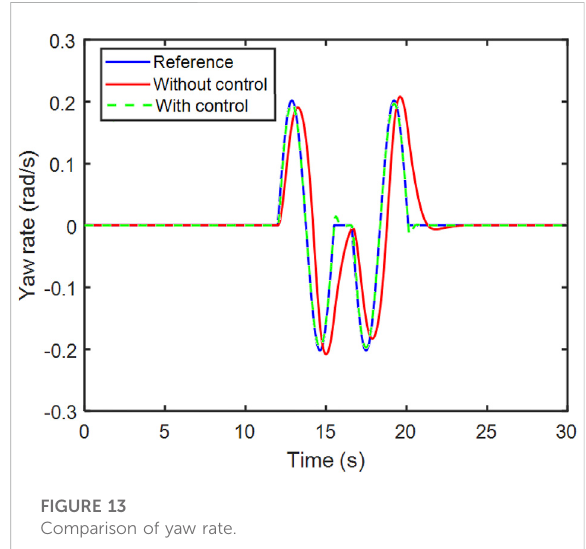
FIGURE 13 Comparison of yaw